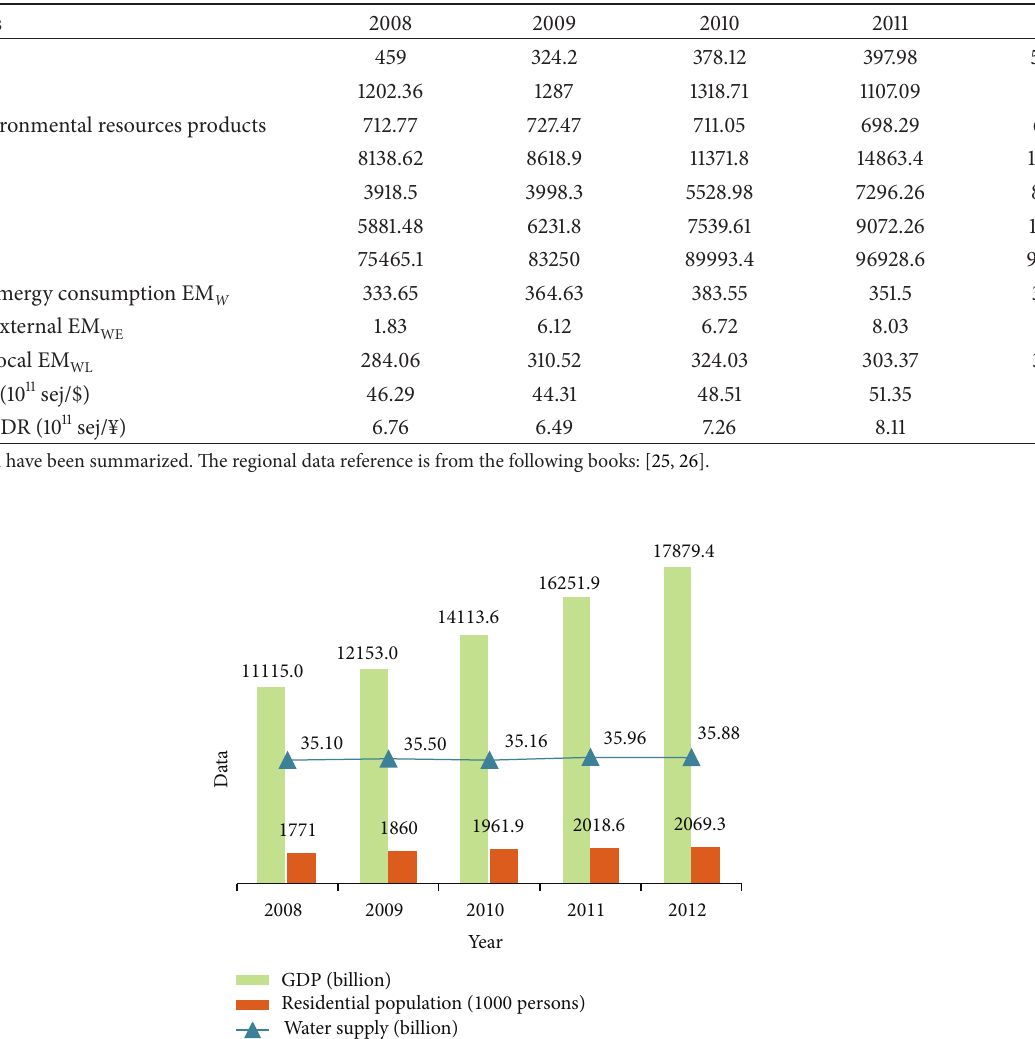
Table 1: The Summary of the main emergy indexes about the water system of Beijing (unit: 10 20 sej).